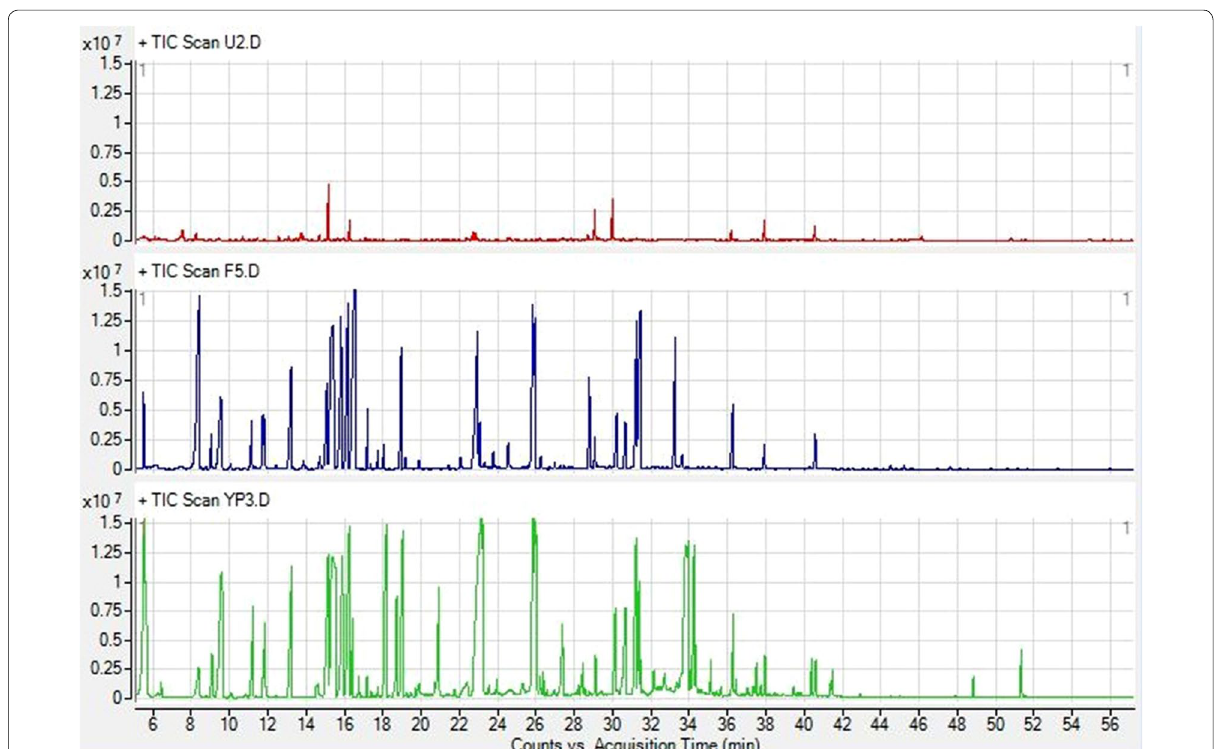
Fig. 4 GCMS chromatograms observed of unfermented BSG media ( top ), fermented BSG media ( middle ) and YP media ( bottom ) when examined to detect metabolites present within